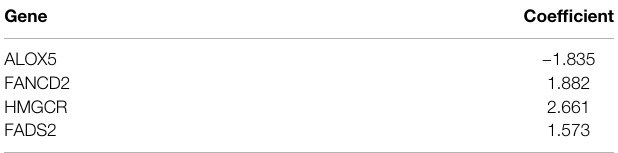
TABLE 2 | Results of Lasso – Cox regression